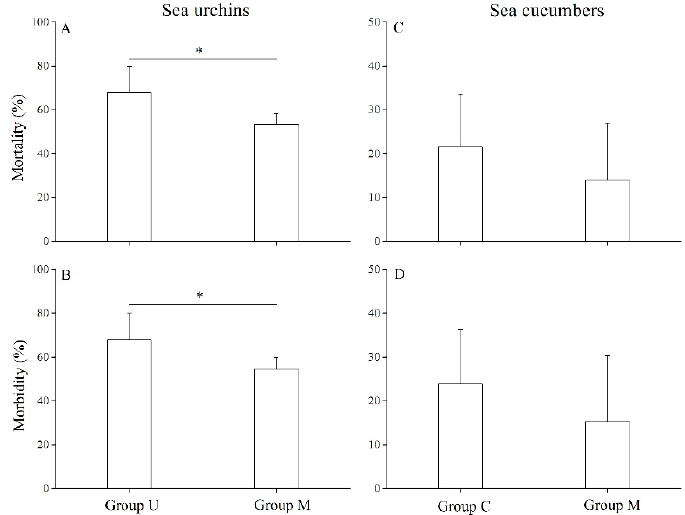
Figure 2. Mortality of Strongylocentrotus intermedius ( A ) and Apostichopus japonicus ( C ) as well as the morbidity of S . intermedius ( B ) and A . japonicus ( D ) between groups (mean ± SD, n = 6). Group C: the control group for sea cucumbers. Group U: the control group for sea urchins. Group M: the integrated multi-trophic aquaculture of sea cucumbers and sea urchins. The asterisk * means p < 0.05.